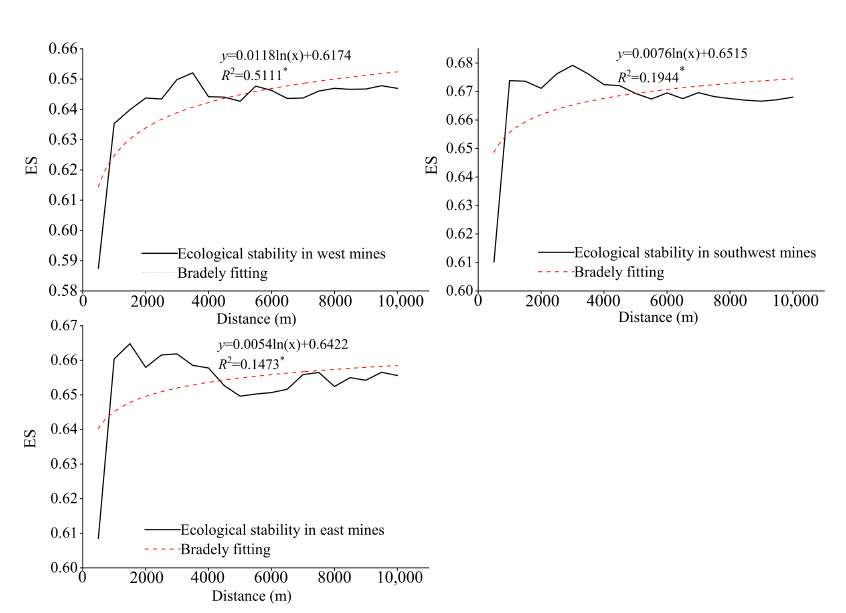
Figure 8. Relationships between ecological stability and distance from coal mining areas in the three mine groups.